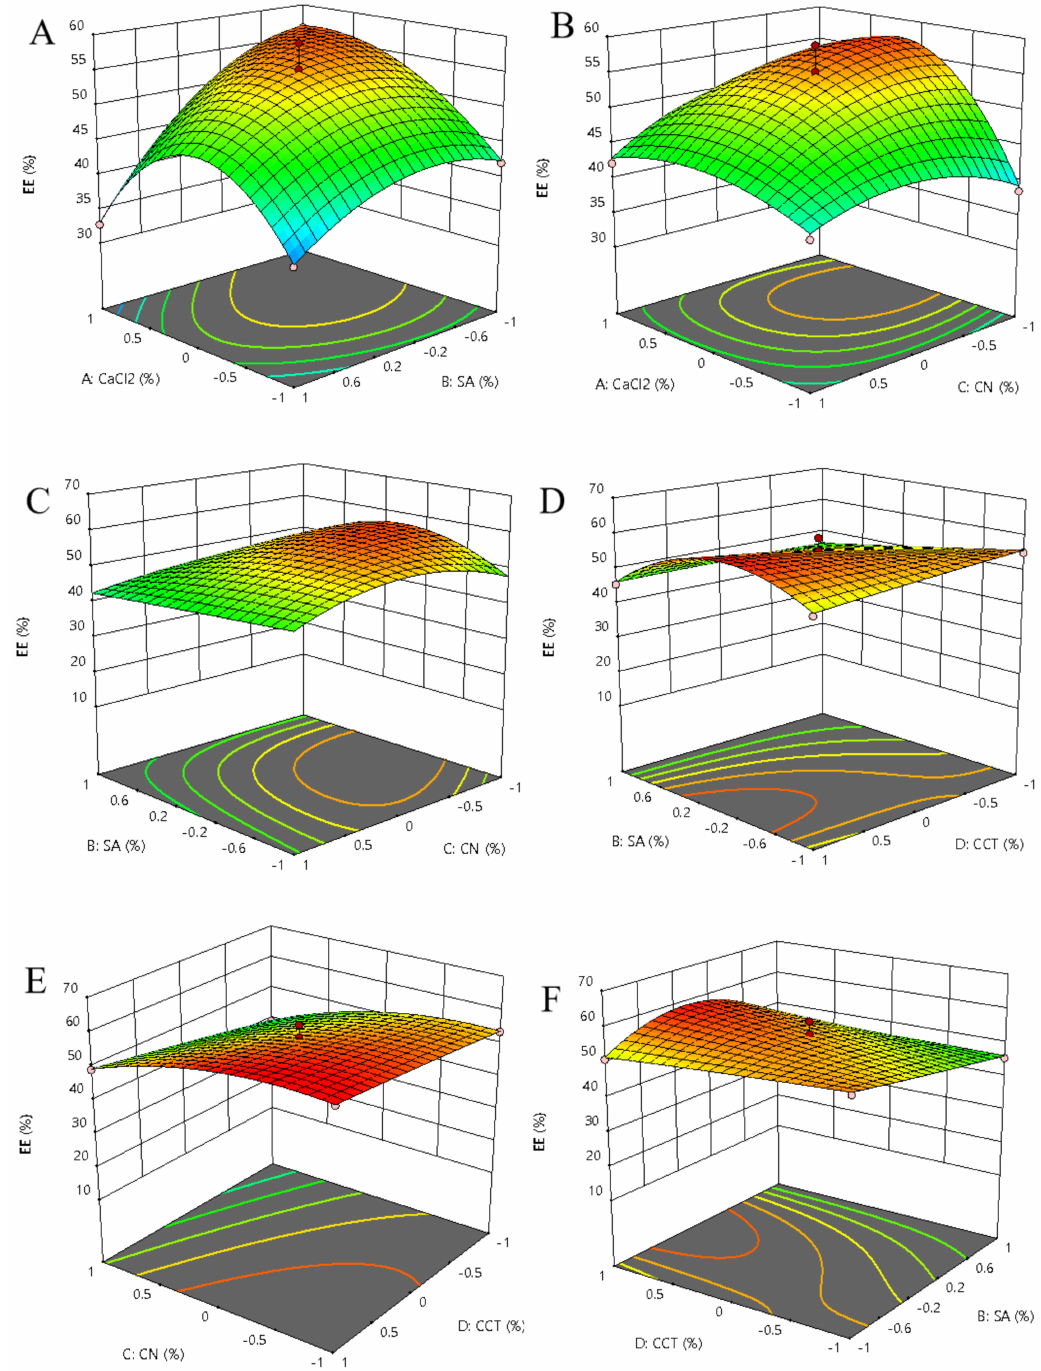
Figure 1. Response surface of the effects among various factors on the encapsulation efficiency of beads. ( A ) Interaction of CaCl 2 and SA; ( B ) Interaction of CaCl 2 and CN; ( C ) Interaction of SA and CN; ( D ) Interaction of SA and CCT; ( E ) Interaction of CN and CCT; ( F ) Interaction CCT and SA. SA: sodium alginate, CN: cellulose nanofibers, CCT: carboxymethyl chitosan, EE: encapsulation